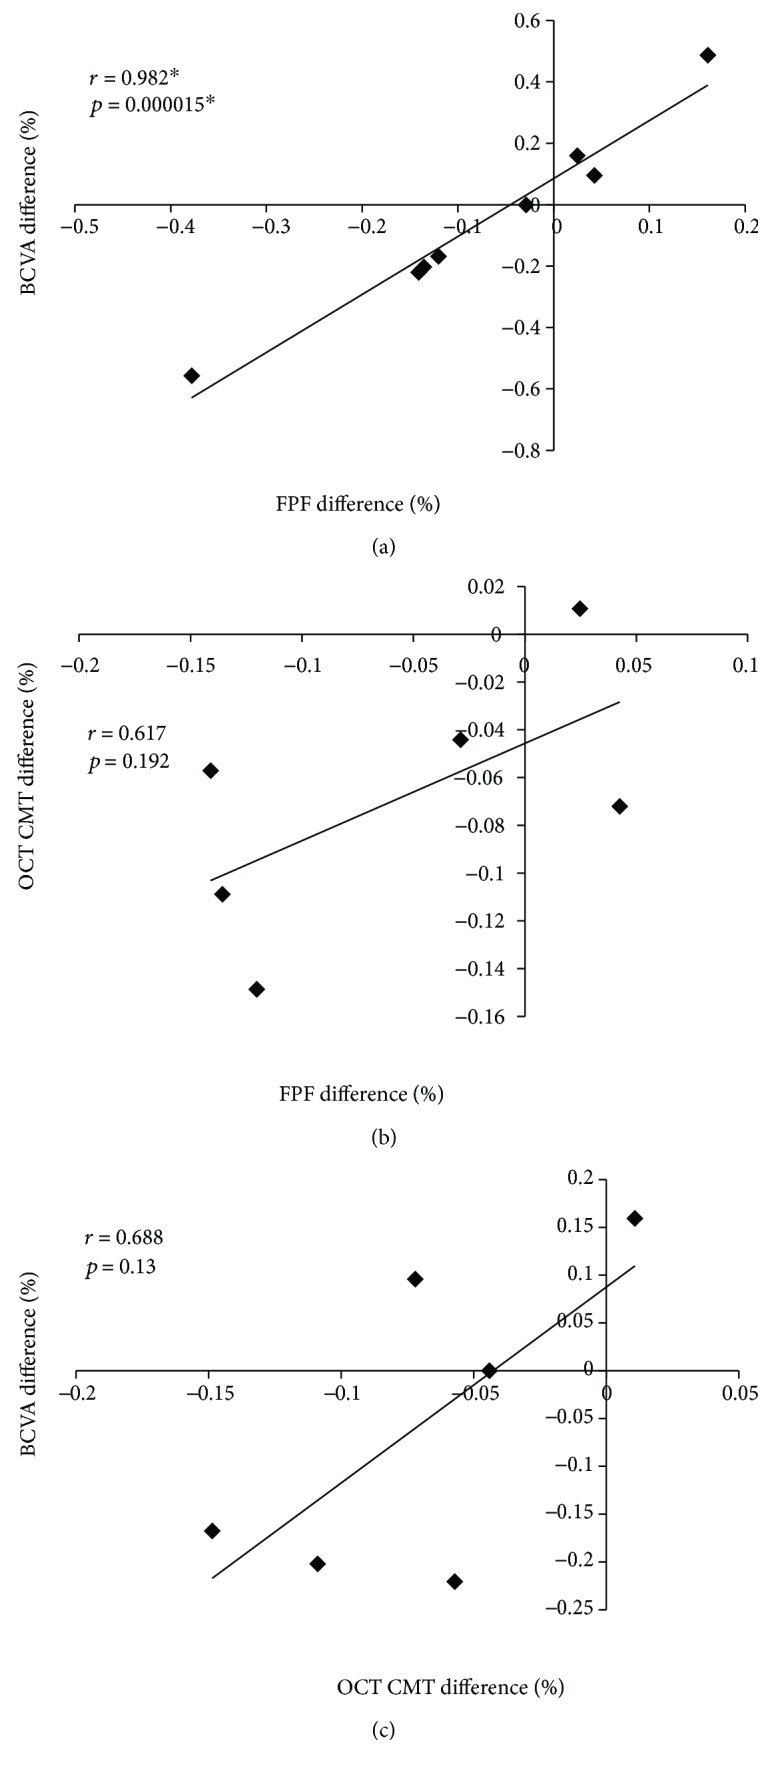
Scatter plot of Pearson's correlation coefficient from: (a) FPF difference (%) versus BCVA difference (%); (b) FPF difference (%) versus OCT CMT difference (%); (c) OCT CMT difference (%) versus BCVA difference (%). ∗ indicates r > 0.7 and p < 0.05.